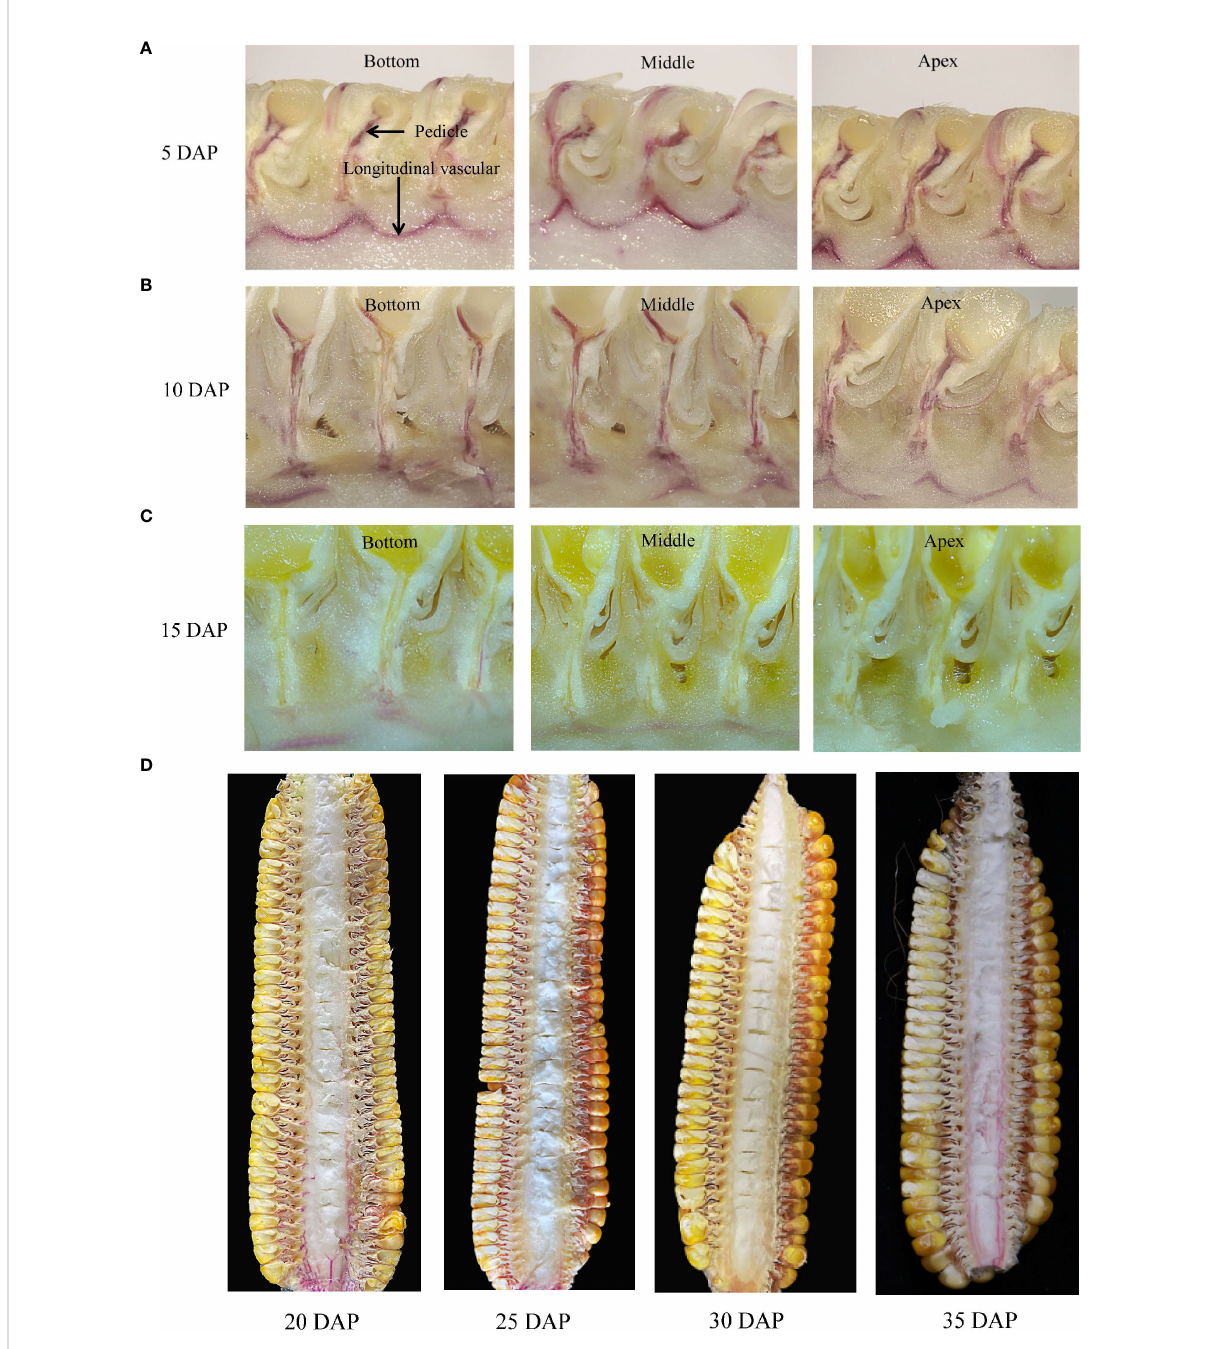
FIGURE 6 Movement of the xylem-mobile dye (basic fuchsin) infused through the stem below the ear- stalk. Longitudinal sections of different parts of the ears at (A) 5 days after pollination (DAP), (B) 10 DAP, (C) 15 DAP, and (D) 20 DAP to 35 DAP for